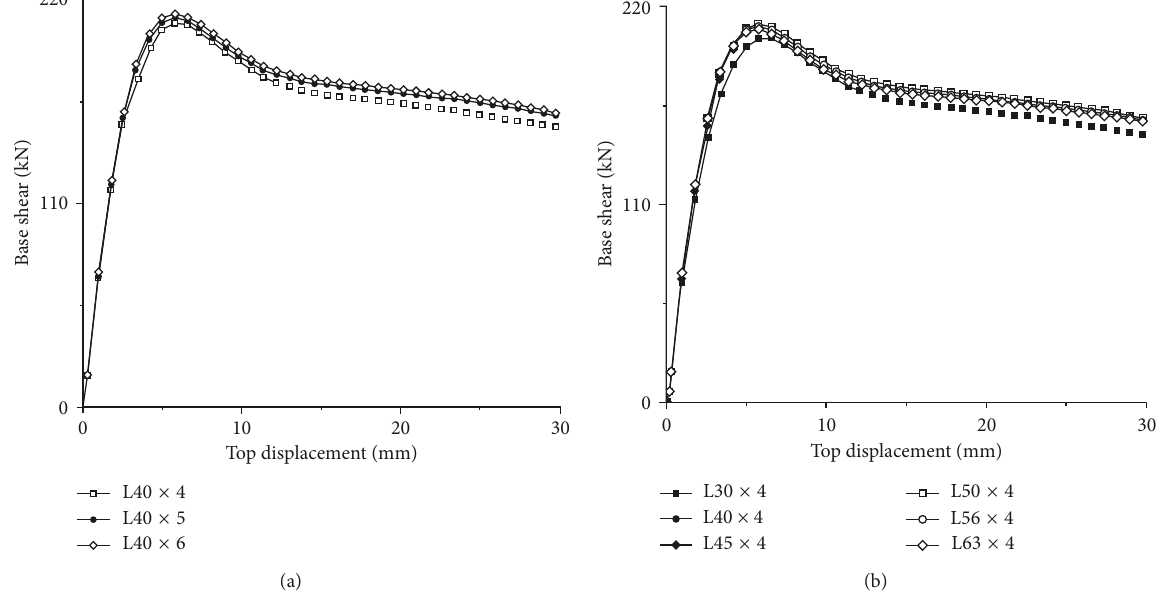
Figure 8: Base shear-displacement curves of the